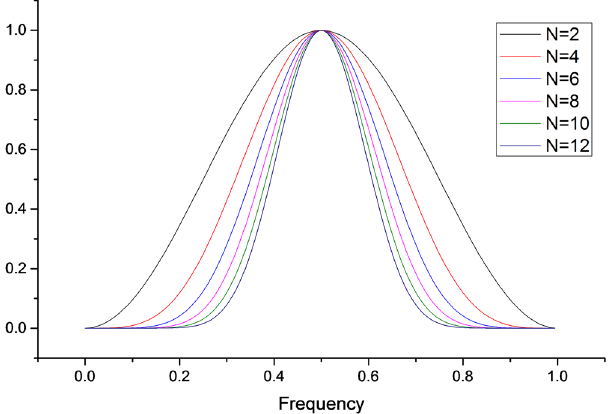
Figure 1. Amplitude-frequency characteristics of the orthogonal wavelet high pass filter with vanishing moments